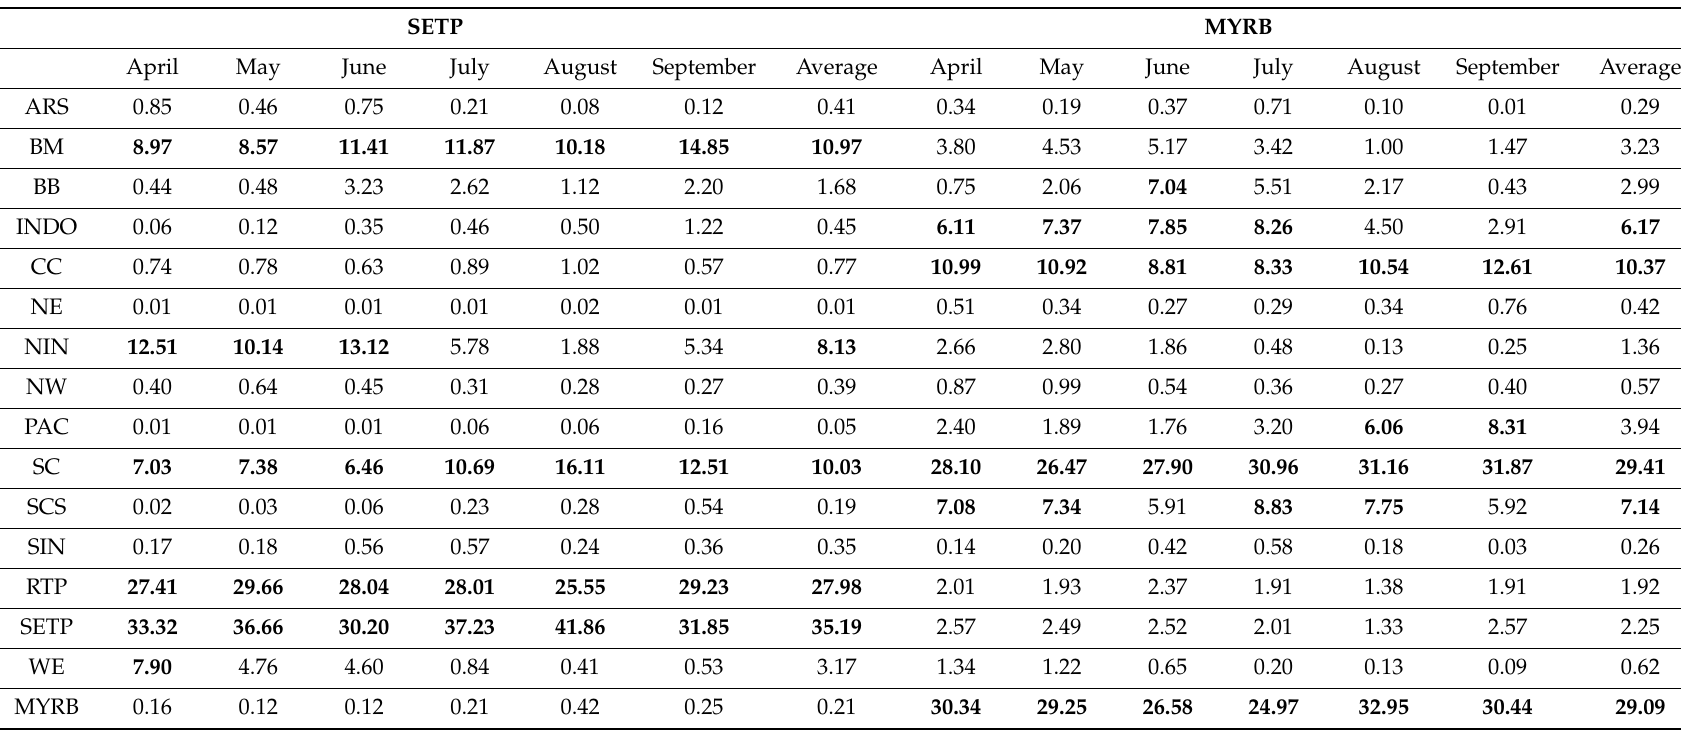
Table 1. Monthly and wet season (April–September) average evaporative sources in the 16 sub-regions, contributing to precipitation (unit: %) in the SETP and MYRB in 1982–2011. Contributions above the average threshold (6%) are marked in